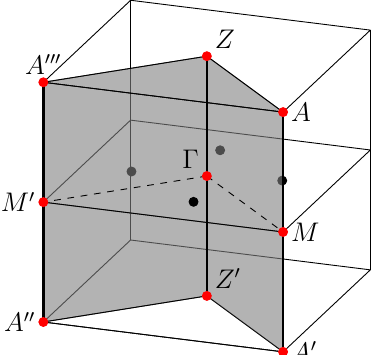
Figure 1: The full BZ with the Weyl points labeled in black dots, and the four-fold rotoinversion points labeled in red dots. Due to the R points, the surface ZAA (cid:48) Z (cid:48) carry a Chern number of 1 / 2. in Sec. 5 we discuss the fate of the gapless hinge modes in the presence of strong surface interactions. In Sec. 6 we show that the chiral hinge modes remain robust in the absence of four-fold rotoinversion